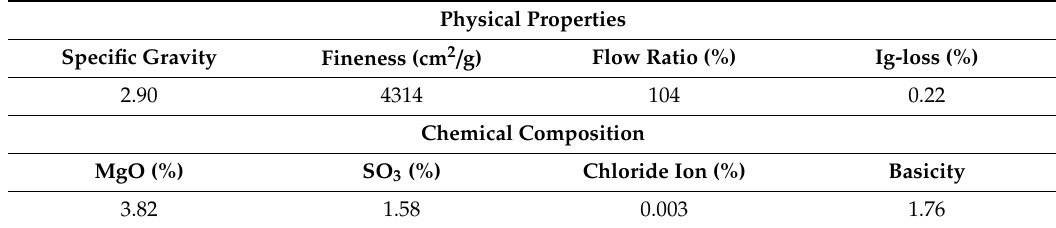
Table 2. Physical properties and chemical composition of blast-furnace slag.